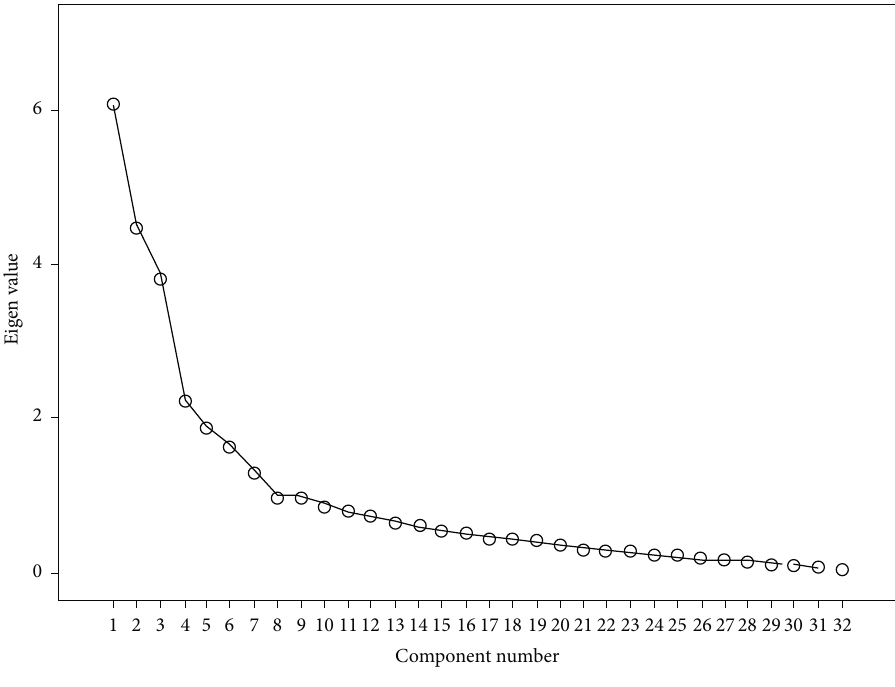
Figure 1: Scree plot of the extractor components of the questionnaire with six fi xed